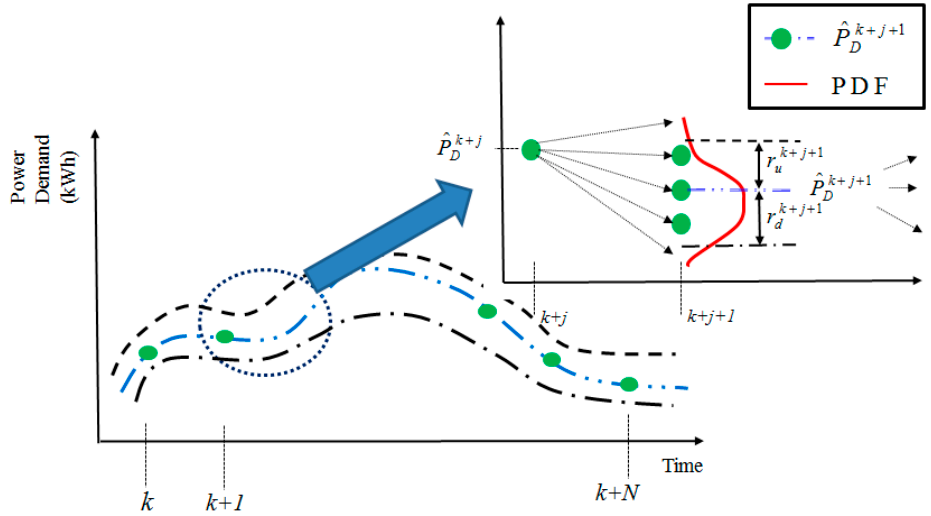
Figure 4. Securing ramping capability from uncertain information. PDF: probability distribution function.